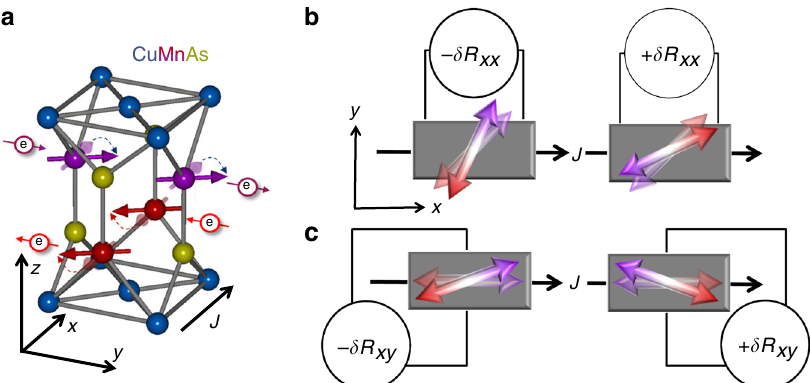
Fig. 1 Microscopic mechanism of the second-order magnetoresistance. a Probing current (black arrow) generates staggered non-equilibrium spin polarization (red and purple electron symbols with arrows) that causes transient de fl ection of the antiferromagnetic moments (thick red and purple arrows on Mn sites). b The 180° reversal of the Néel order probed by the current-dependent resistance δ R xx , associated with the electrically induced de fl ection of antiferromagnetic moments (double-arrows) combined with AMR, for equilibrium antiferromagnetic moments (semi-transparent double-arrows) aligned at an angle 45° from x axis of the probing current. c Same as b for δ R xy and equilibrium antiferromagnetic moments aligned with x